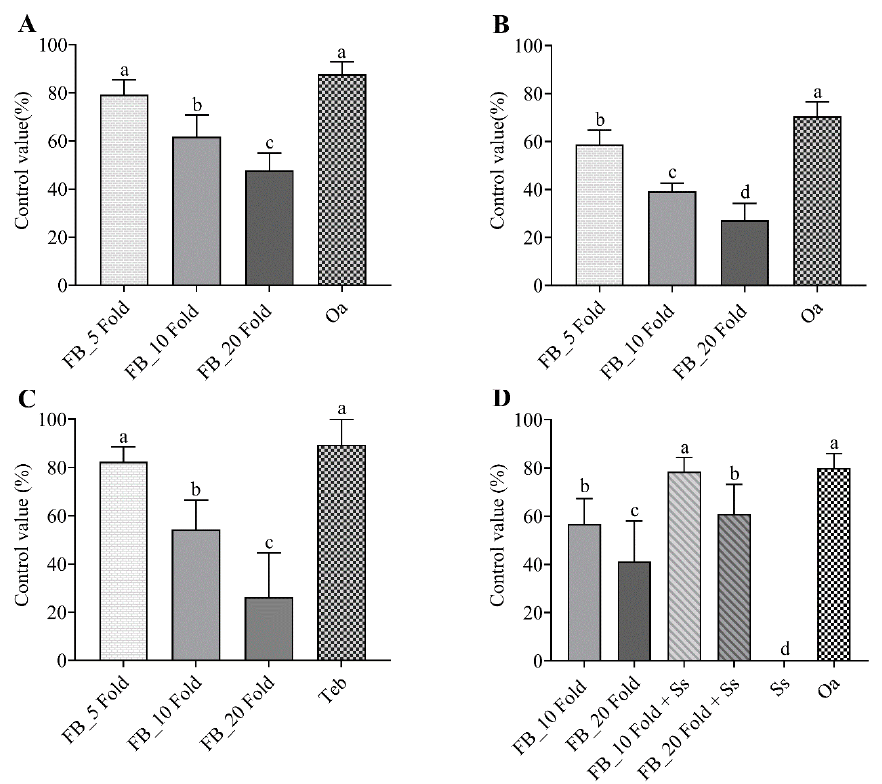
Figure 3. Biocontrol efficacy of the fermentation broth (FB) of Streptomyces sp. AN090126 against bacterial wilt of tomato caused by R. solanacearum ( A ), leaf spot of red pepper caused by X. euvesicatoria ( B ), dollar spot of creeping bentgrass caused by S. homoeocarpa ( C ), and soft rot of Kimchi cabbage caused by Sr-Pcc ( D ). In vivo assays were performed by FB of Streptomyces sp. AN090126 using the soil drenching method for controlling tomato bacterial wilt, creeping bentgrass dollar spot and Kimchi cabbage soft rot, and foliar spray for red pepper leaf spot diseases. Two bactericides (200 µg/mL of Oa and 200 µg/mL of Ss) or one fungicide (tebucolazole, Teb; 125 µg/mL) were used as positive control(s). FB_5 Fold, 10 Fold and 20 Fold = 5, 10, and 20-fold dilutions of the FB of Streptomyces sp. AN090126. Values are presented as the mean ± standard deviation of three runs with triplicates. Bars with the same letters are not significantly different between treatments ( p < 0.05) followed by Fisher’s least significant difference test.